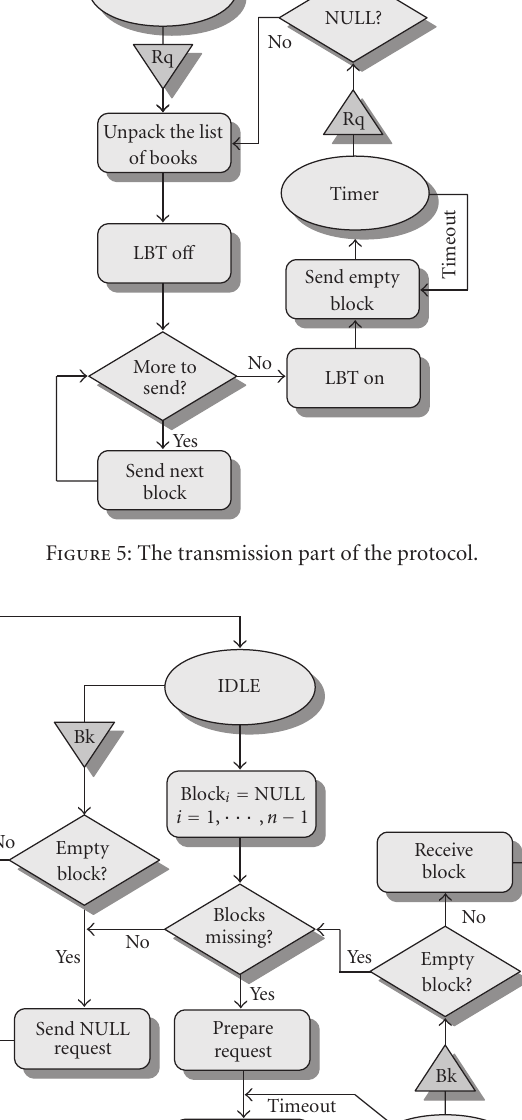
from the other party. For an immediate transmission-while- sampling request, the first request issued by the CPP will instruct the HDL to initiate the sampling procedure, and will implicitly trigger the first “total” window consisting of all the blocks contributing to the